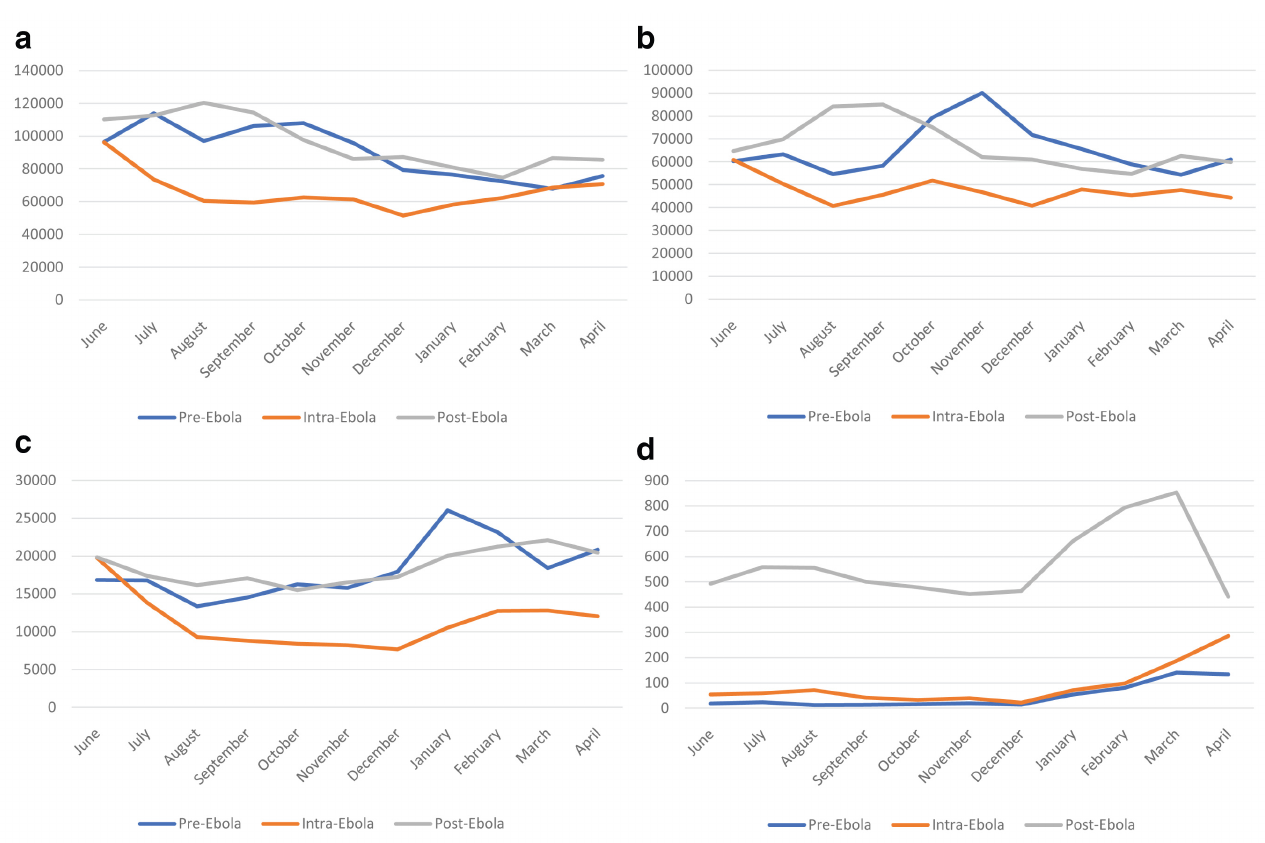
Figure 1. Trends in consultations for childhood morbidities in the pre-Ebola (1 June 2013–30 April 2014), intra-Ebola (1 June 2013–30 April 2014), and post- Ebola (1 June 2016–30 April 2017) periods, Sierra Leone. a ): Malaria consultations in the pre- Ebola, intra-Ebola and post-Ebola periods. b ) ARI/Pneumonia consultations in the pre-Ebola, intra-Ebola and post-Ebola periods. c ) Watery diarrhea consultations in the pre-Ebola, intra-Ebola and post-Ebola periods. d ) Measles consultations in the pre-Ebola, intra-Ebola and post-Ebola periods.